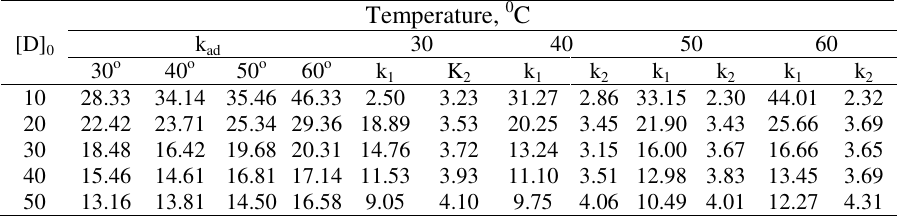
, min -1 ) and the ad , min -1 ) 2